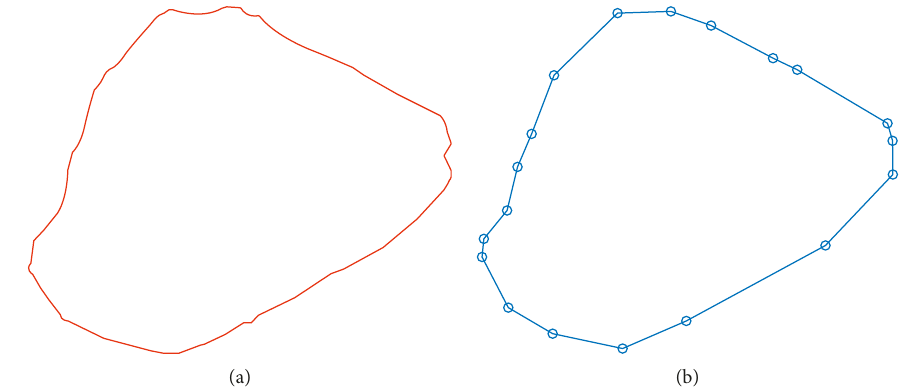
Figure 2: Contour points’ simplification. (a) Original contour points. (b) Key control points.